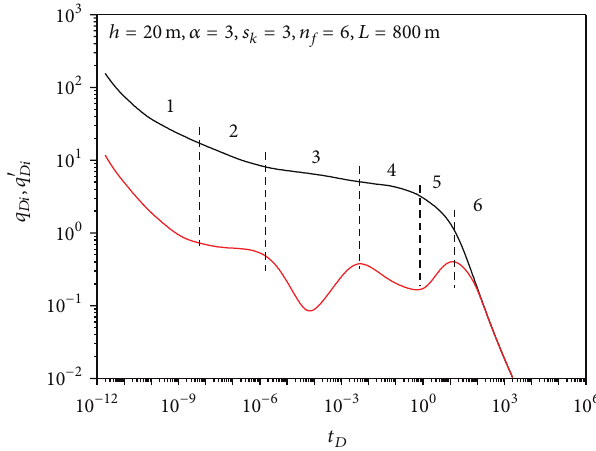
Figure 4: Type curve of production decline for two-phase flow in multistage hydraulic fractured horizontal well in